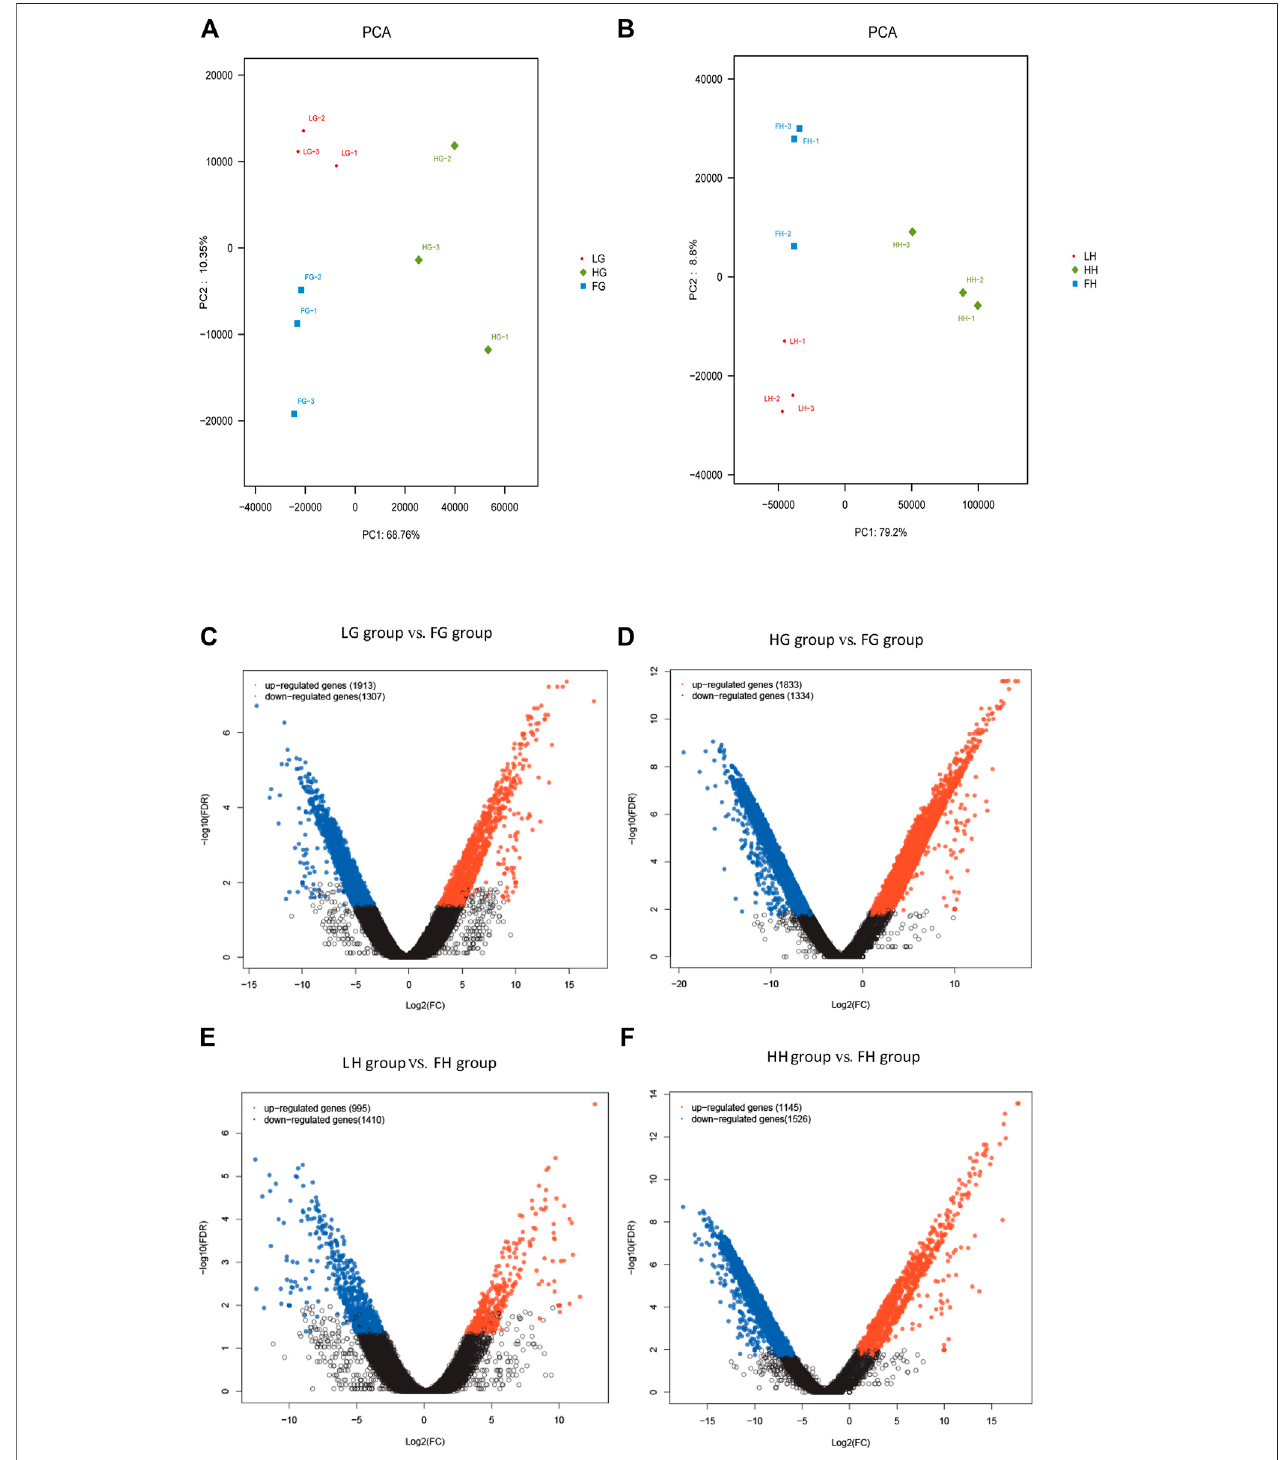
FIGURE 2 | Analysis of DEGs. (A,B) Principal component analysis plot of transcriptome data obtained on assessing the gill and hepatopancreas tissues of M. nipponense . Analysis of DEGs identi fi ed in the gill and hepatopancreas tissues from the control vs low salinity group (C,E) and the control vs high salinity group (D & F) . Up- and downregulated DEGs are shown in red and blue, respectively. The X- and Y -axes show the log 2 -fold change and log 10 p -value of normalized expression level (fragments per kilobase of transcript per million mapped reads) of a gene between the aforementioned groups, respectively.